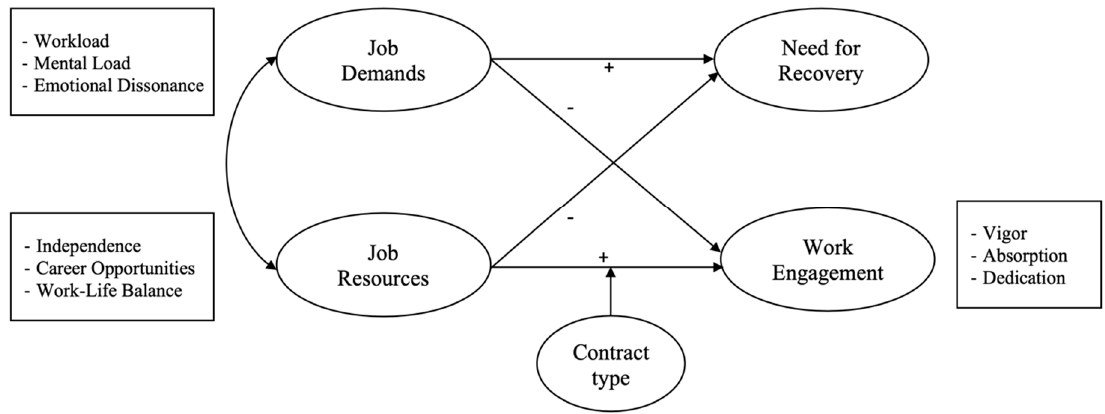
Figure 1. The conceptual model of the hypothesized relationships between variables.